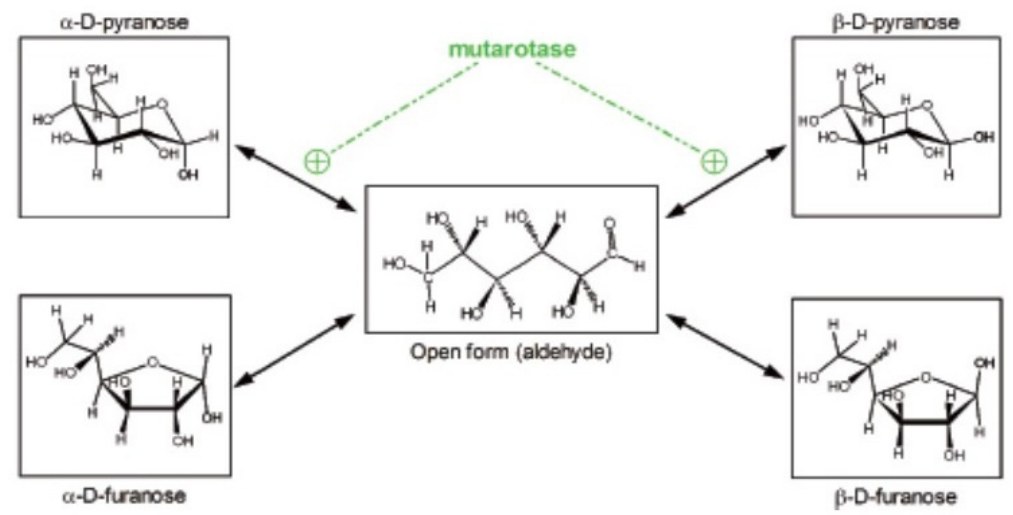
Figure 1. Different structures of the glucose molecule present in biological systems. From Oliva et al. 2019 [10].